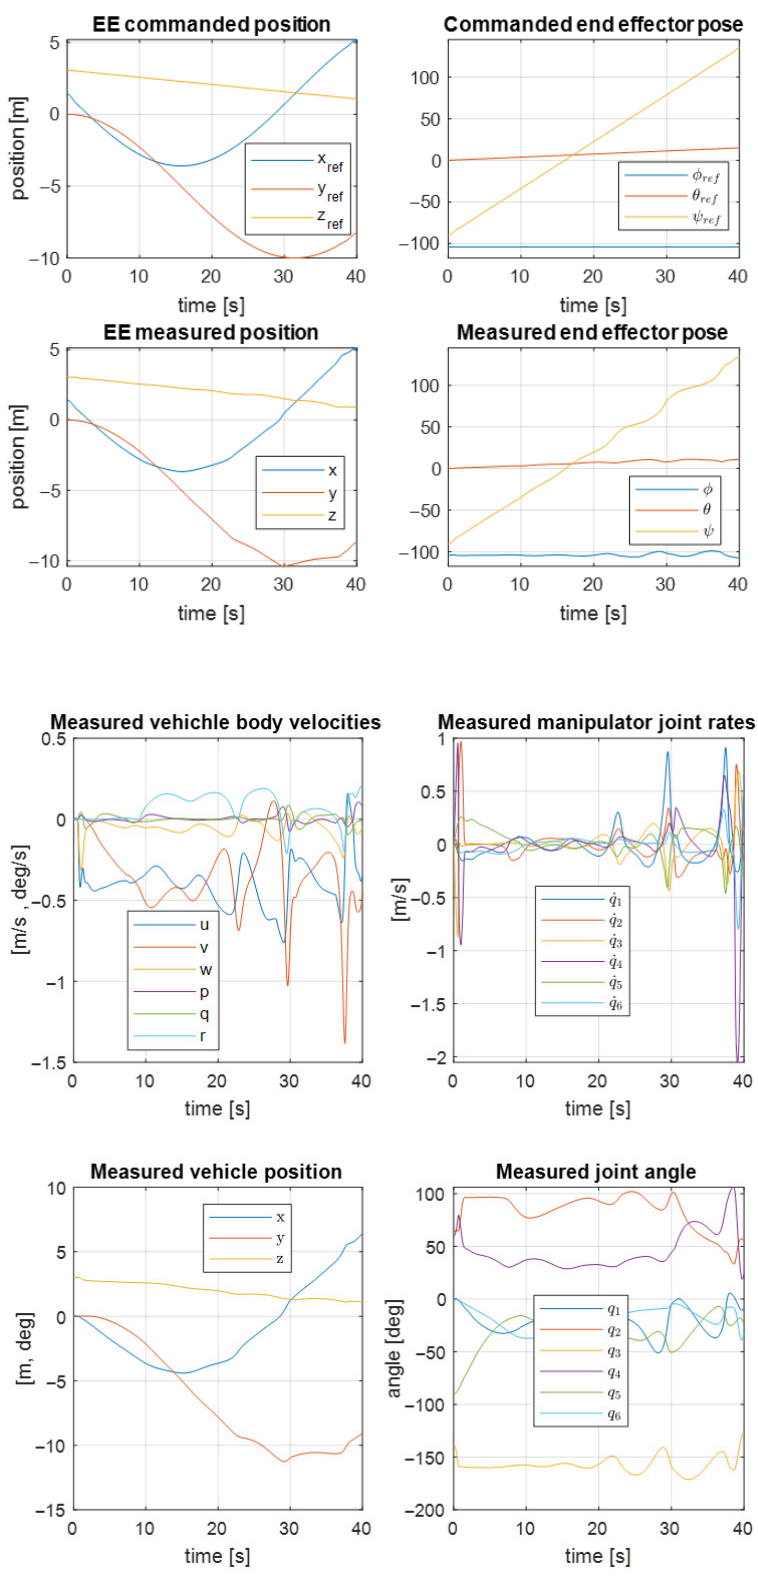
Figure 11. Measured and commanded positions of the first UVMS. Analogous results for the second UVMS are shown in Figure 12. As a result, the trajectory controller works correctly according to the system